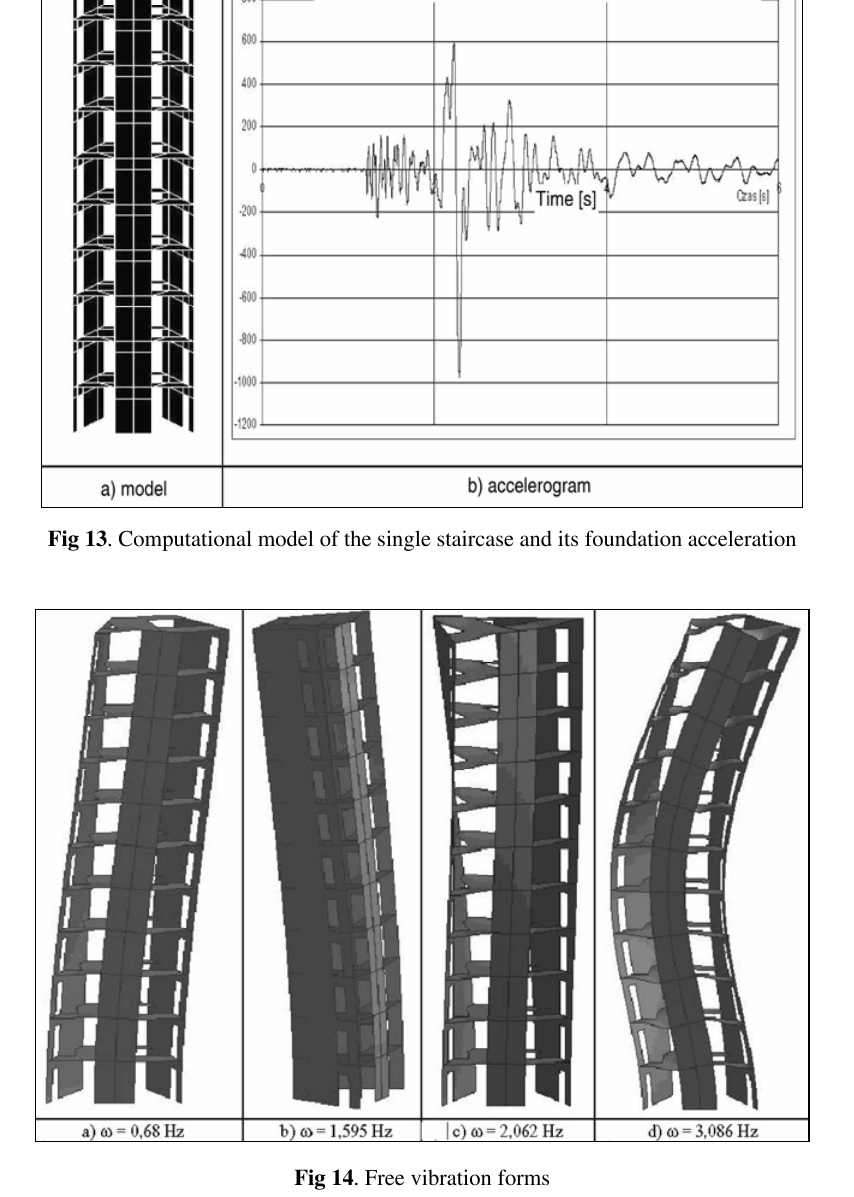
Fig 14 . Free vibration forms